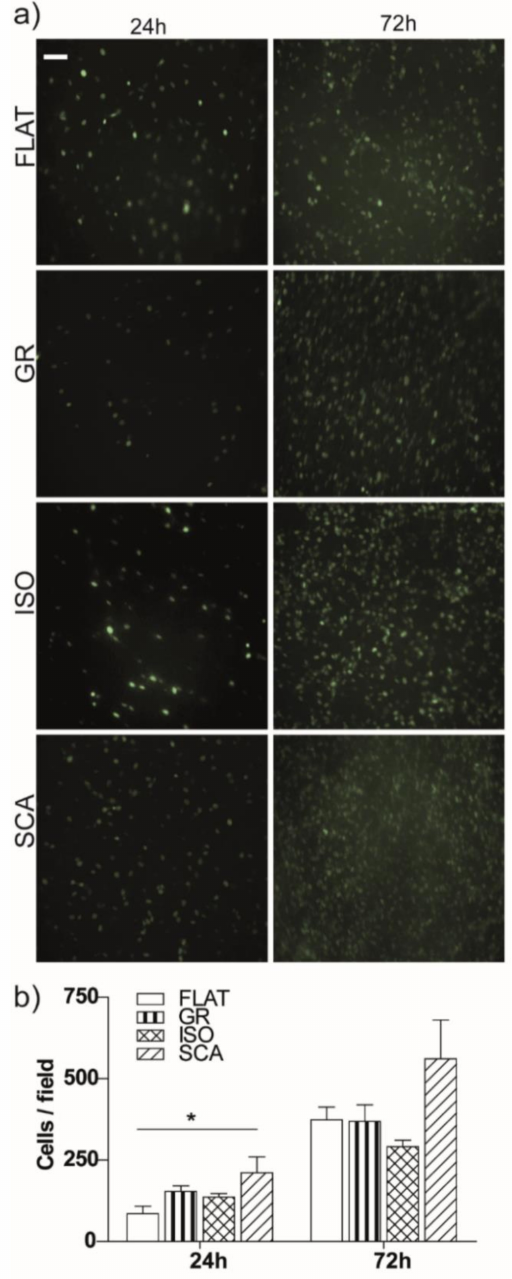
Figure 3. RT4-Schwann cell proliferation. ( a ) Fluorescence microscopy images of RT4-SCs at t = 24 h and t = 72 h, on FLAT, GR, ISO and SCA chitosan membranes. The nuclei are visible in green (GFP). Scale bar = 70 µ m. ( b ) The proliferation rate of RT4-SCs on GR, ISO and SCA micro-structured membranes and on the FLAT control, reported as cells/field at t = 24 and 72 h. As a comparison, we report that the number of RT4-SCs on the standard cell plates (seeded in parallel and in the same conditions as the chitosan films) was 183.3 ± 63.9 cells/field at 24 h. * p < 0.05, one-way ANOVA, Bonferroni’s test. Data = mean ± SEM, n =